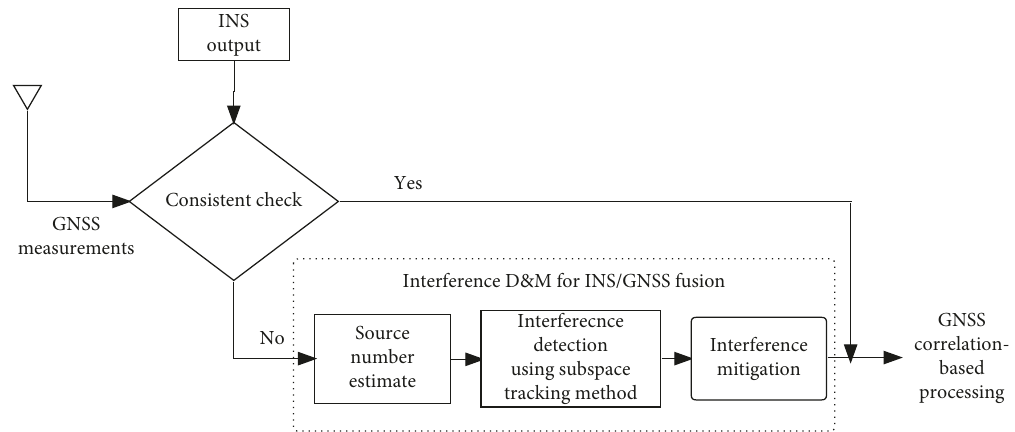
Figure 1: Overview of the proposed